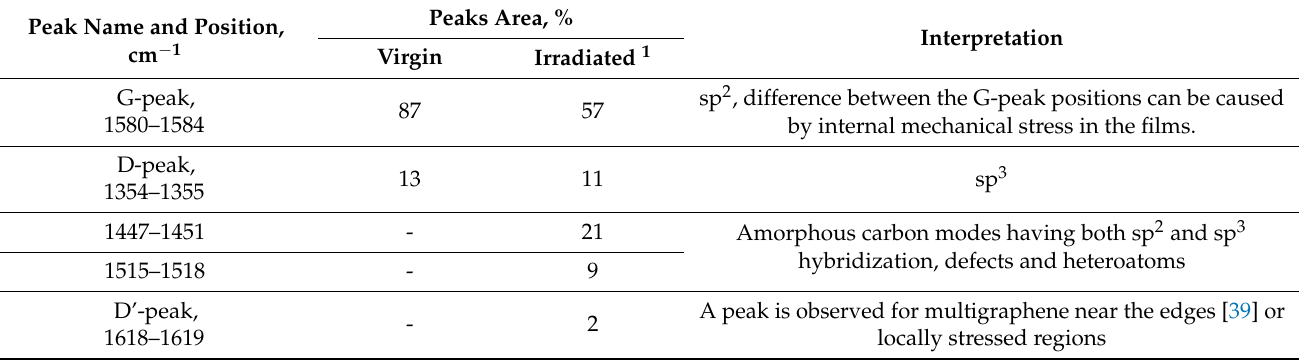
Table 1. The results of Raman spectra fitting for virgin and irradiated CVD FLG films. Peaks Area, % Peak Name and Position, Interpretation cm − 1 Virgin sp 2 , difference between the G-peak positions can be caused 87 57 by internal mechanical stress in the